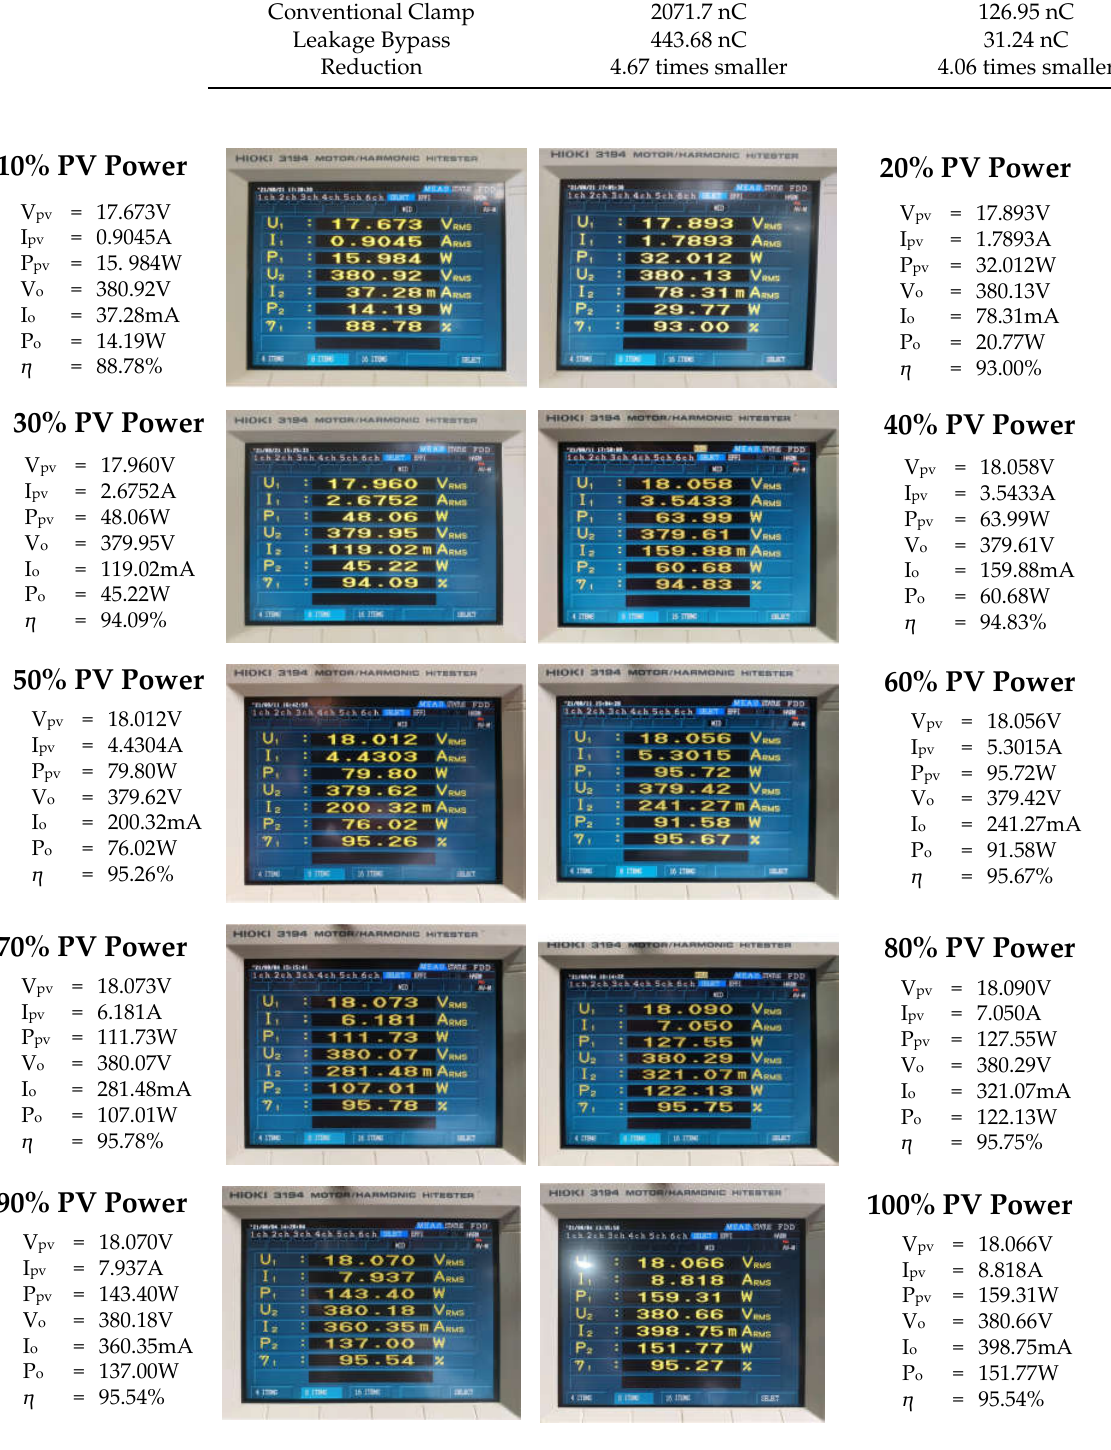
Figure 19. Experimental power measurements. V 1 : PV Voltage; I 1 : PV Current; P 1 : PV Power; V 2